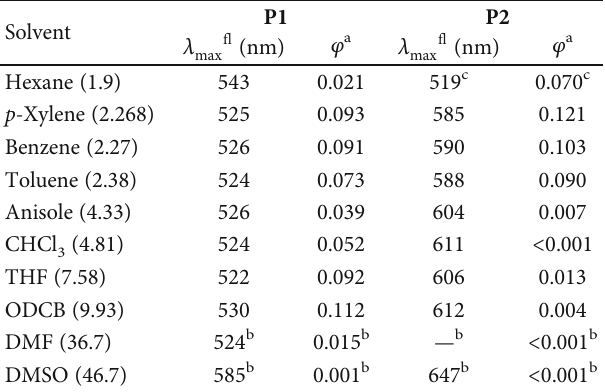
Figure 7: Absorbance-corrected fl uorescence emission (excited at the corresponding absorption maximum) spectra of P1 and P2 as very dilute solutions (maximum absorbance: ca. 0.1) in di ff erent solvents. Note that P2 has poor solubility in hexane, and the upper, clear portion of a saturated P2 solution in hexane was collected and diluted for measurement. Also, note that due to the very poor solubility of P1 and P2 in DMF and the insolubility of P1 and P2 in DMSO, these solutions were prepared by adding a very small amount of concentrated CHCl stock solution of P1 or P2 to respective solvents. 3 Table 2: Emission maxima (excited at the corresponding absorption maximum) and fl uorescence quantum yields of P1 and P2 as very dilute solutions (maximum absorbance: ca. 0.1) in di ff erent